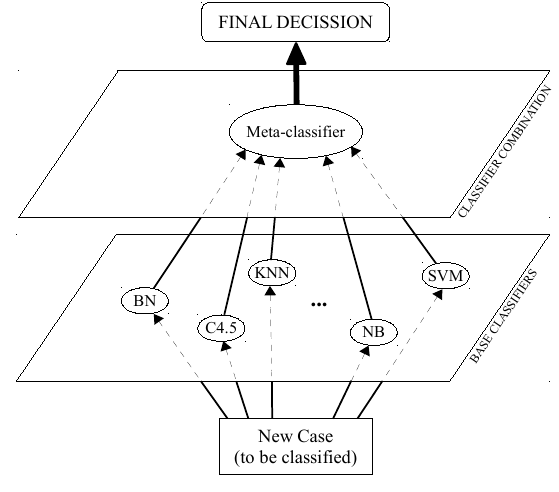
Figure 1. Stacked generalization